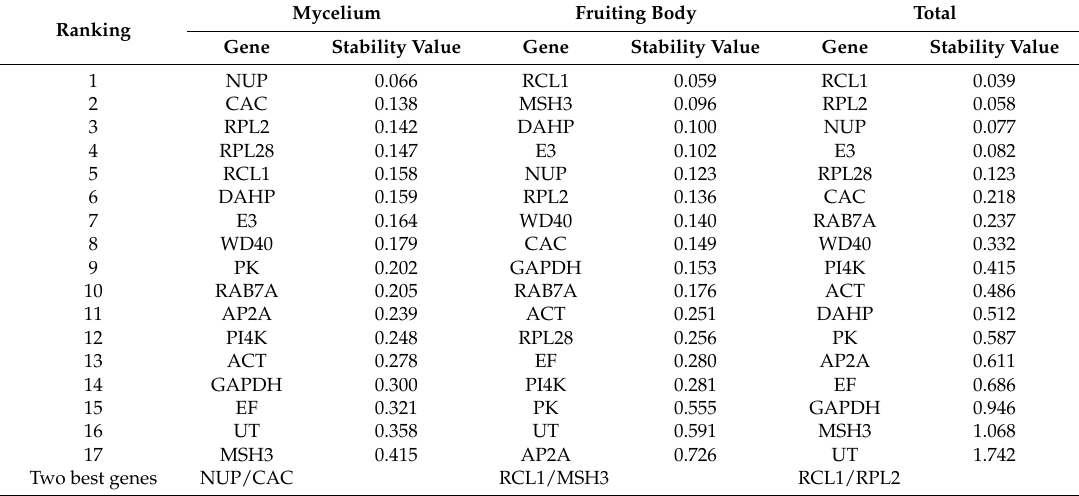
Table 2. Ranking of candidate reference genes according to